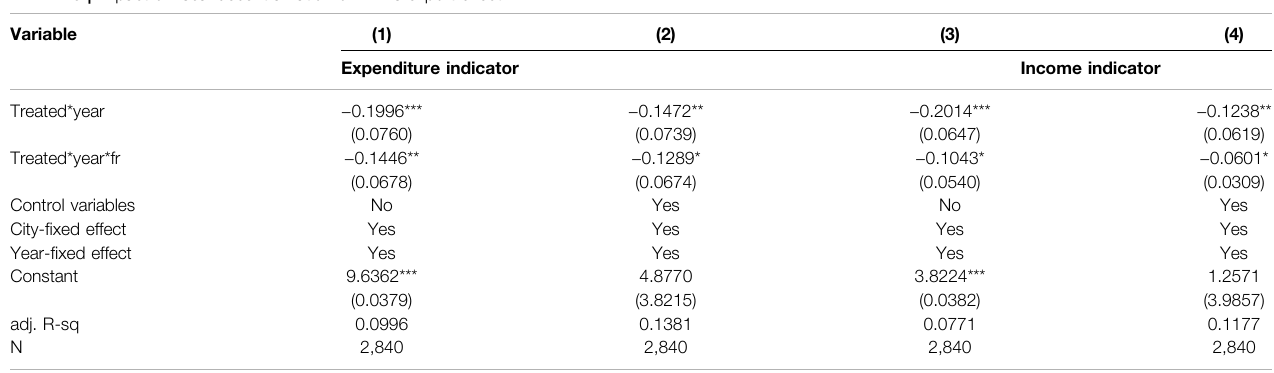
TABLE 3 | Impact of fi scal decentralization on EID ’ s export effect. Variable